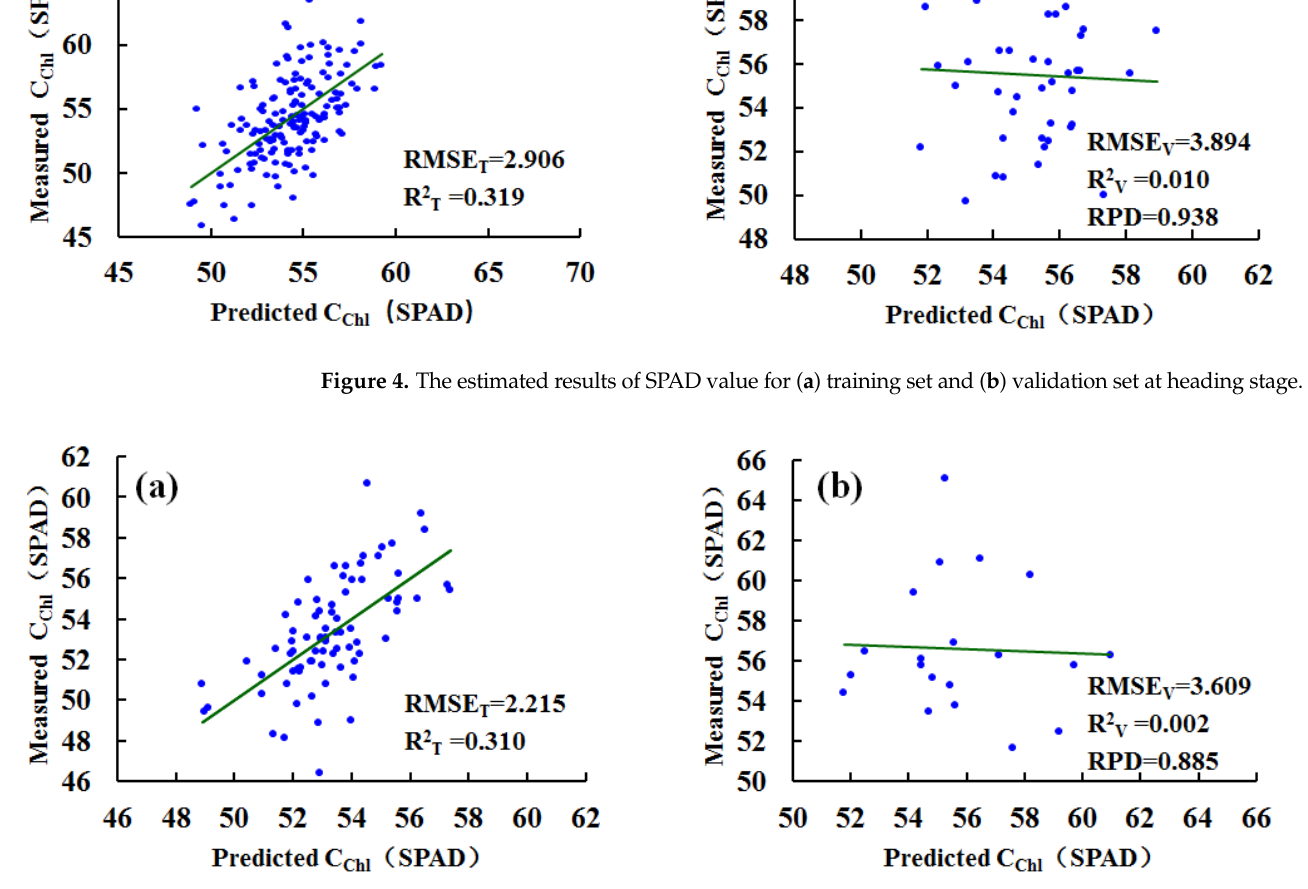
Figure 6. The estimated results of SPAD value for ( a ) training set and ( b ) validation set at filling stage.